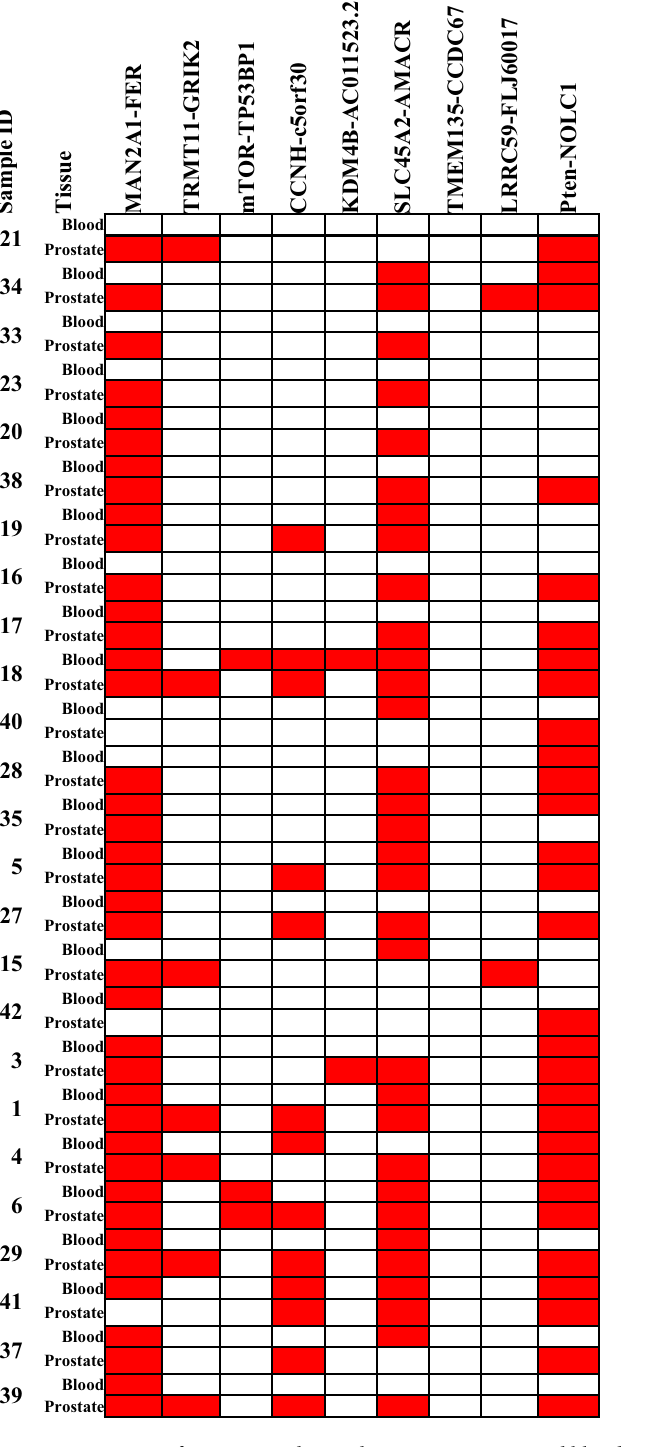
Figure 1. Heatmap fusion genes detected in prostate cancer and blood samples from the same patients. Case number is indicated. Red color indicates a positive detection of the indicated fusion transcript. Blank indicates a negative